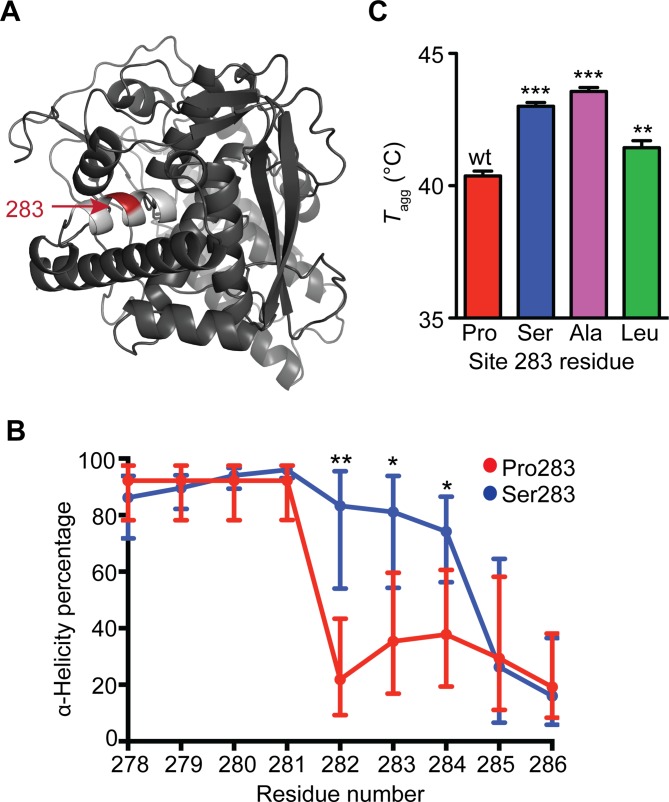
Pro283 disrupts nucleoprotein α-helical content and is destabilizing relative to other variants at site 283.(A) Nucleoprotein crystal structure reveals site 283 is in the center of an α-helix (PDB ID: 2IQH [36]). (B) Molecular dynamics simulations show that Pro283 disrupts nucleoprotein α-helical content compared to Ser283. A Student t test indicates significant differences at sites 282–284. Replicate α-helicity percentages are provided in S6 Data. (C) Apparent (irreversible) melting temperatures (Tagg) of wild-type and site 283 nucleoprotein variants evaluated by circular dichroism. Student t test indicates the significance of deviation from wild-type apparent melting temperature. Replicate apparent melting temperatures are provided in S7 Data. Ala, alanine; Leu, leucine; PDB, Protein Data Bank; Pro, proline; Ser, serine.